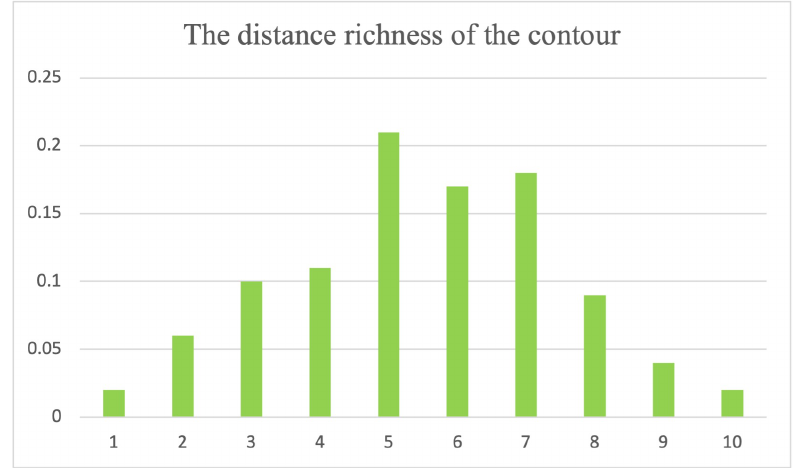
Figure 7. This histogram shows the distance distribution of the local contour in the MBR, which is also the specific representation of the contour distance